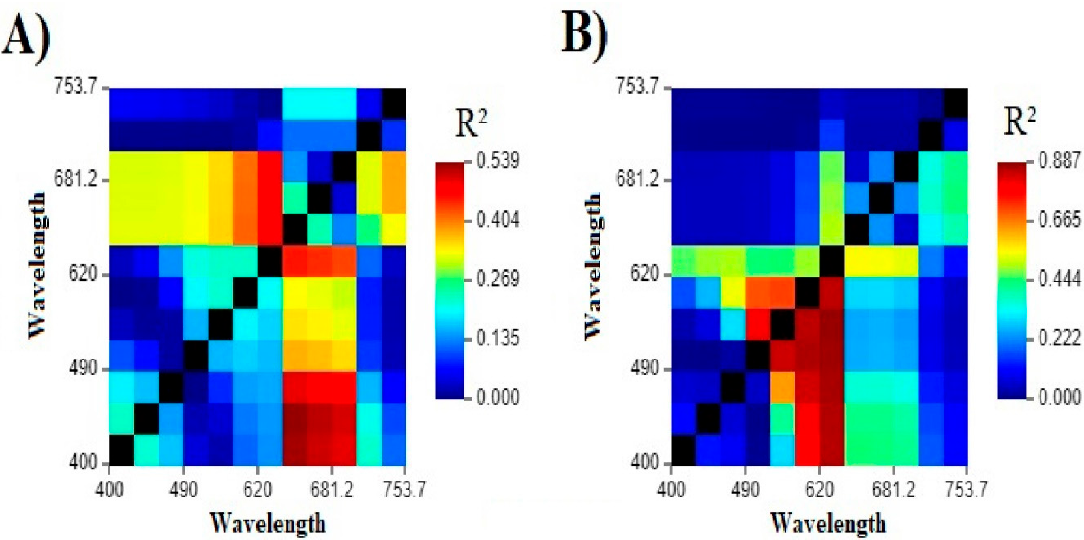
Figure 7. 2D color R 2 plots higher concentrations (>50 µg/l) A ) For PC concentration; B ) For chl- a